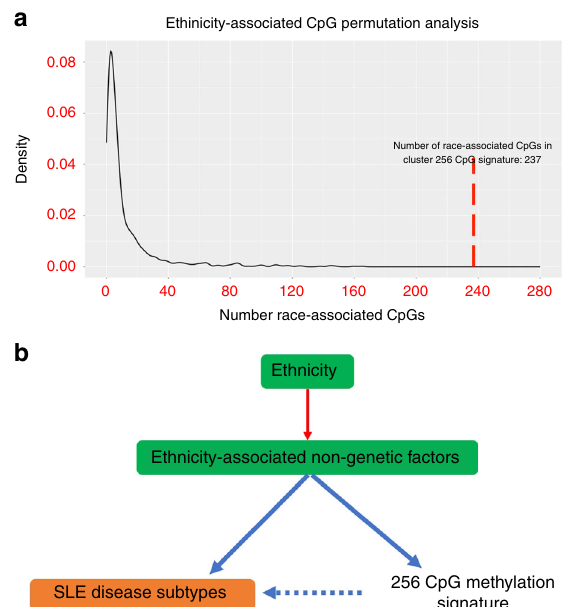
Fig. 6 Enrichment of ethnicity-associated CpGs in set of cluster-associated CpGs. a Null distribution generated by randomly permuting ethnicity labels 1000 times and identifying the number of cluster associated CpGs that were also signi fi cantly with ethnicity ( p < 0.05) in each sample. The red line indicates the number of signi fi cant ethnic-associated CpGs (238) found in the set of 256 cluster-associated CpGs. b Working model illustrating the role of ethnic-associated non-genetic factors in controlling both SLE